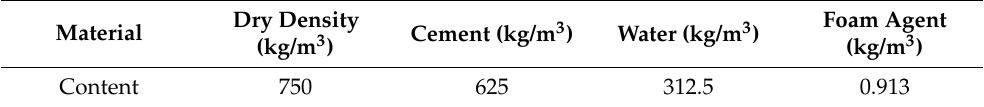
Table 3. The mix design of the foam concrete.